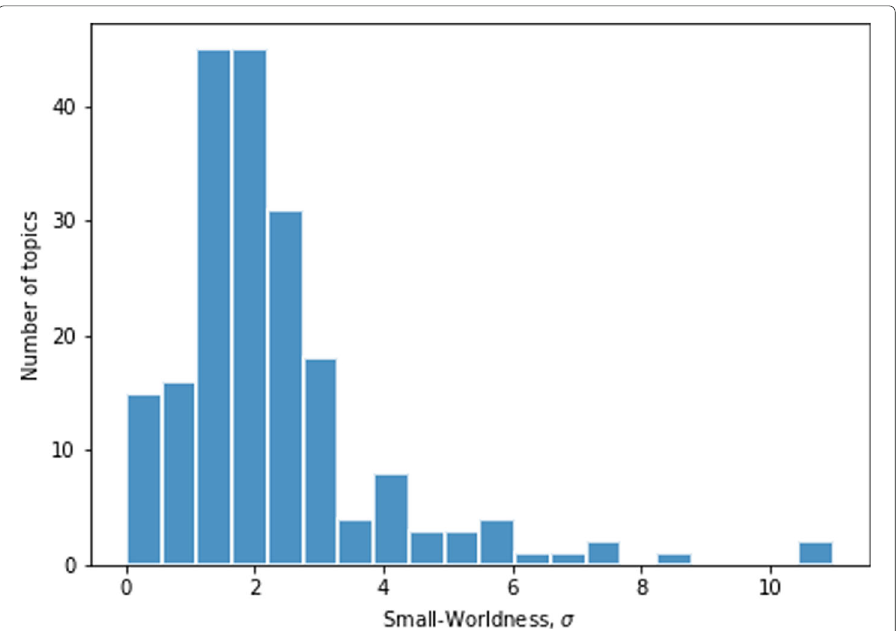
Fig. 8 Histogram showing the distribution of small-worldness, σ . A value of σ < 1 is considered not to be